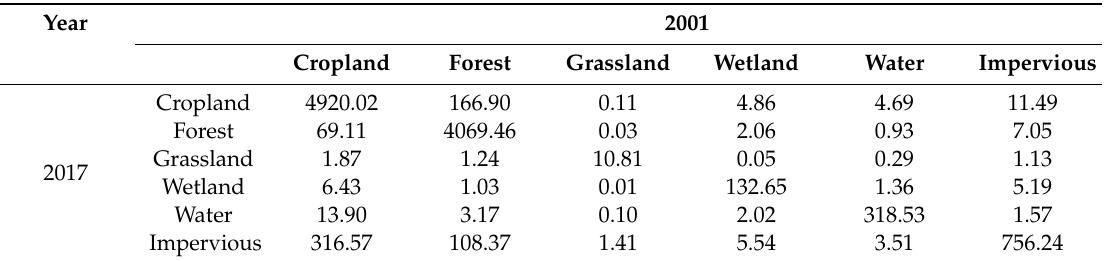
Table A2. LULC transformation area (km 2 ) matrix from 2001 to 2017 in this study